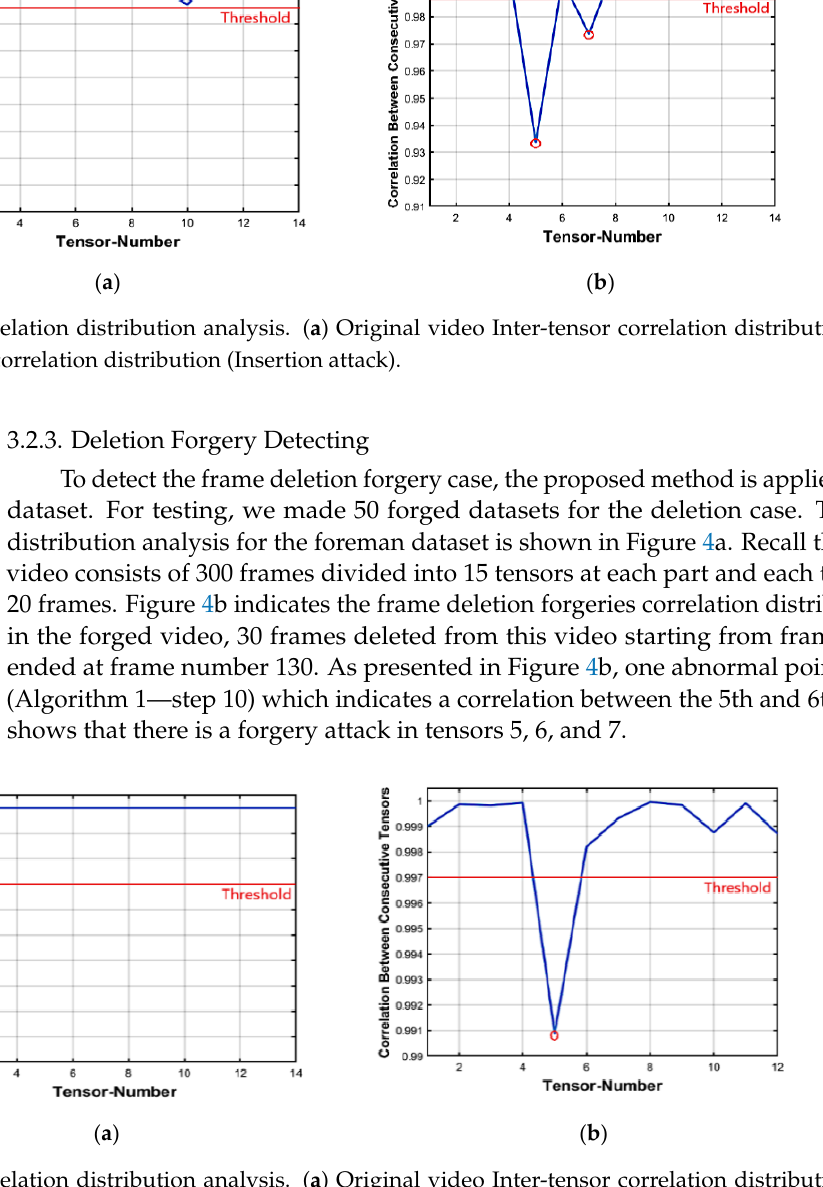
Figure 4. Inter-tensor correlation distribution analysis. ( a ) Original video Inter-tensor correlation distribution and ( b ) Forged video Inter-tensor correlation distribution (Deletion attack).